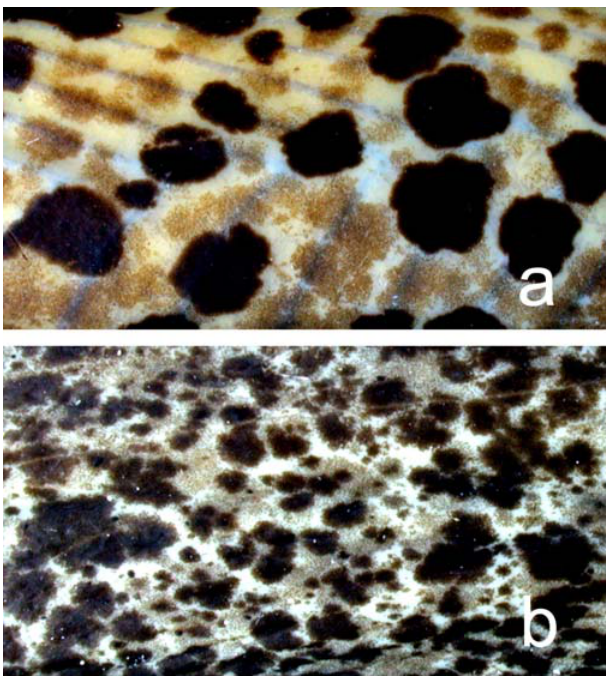
Fig. 2 . Color pattern of (a) Synbranchus lampreia , MPEG 3377, 704.0 mm TL, and (b) Synbranchus marmoratus , MPEG 3375, 630.0 mm TL. Both from Brazil, Pará, ilha de Marajó, rio Goiapi.